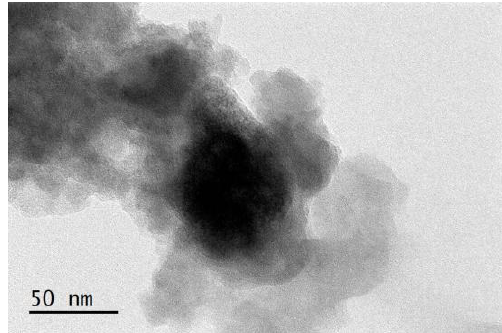
Figure 4. HRTEM morphology of CSPs.